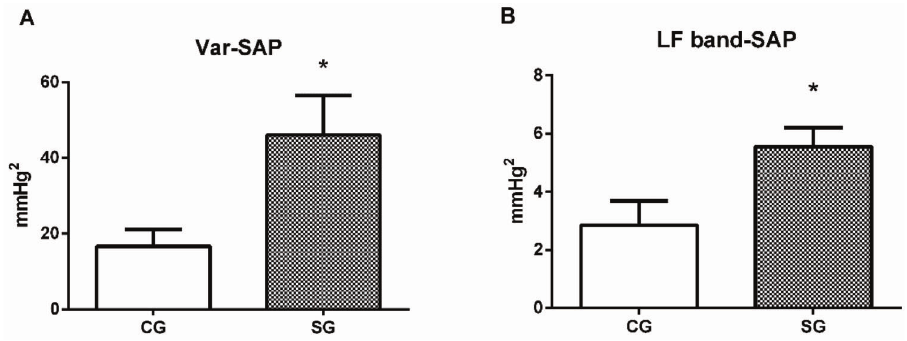
Figure 1 - Blood pressure variability. (A) Variance in systolic arterial pressure (Var-SAP). (B) Low-frequency systolic arterial pressure (LF-SAP). CG: control group. SG: stroke group. Student ’ s t test. * p o 0.05 vs.